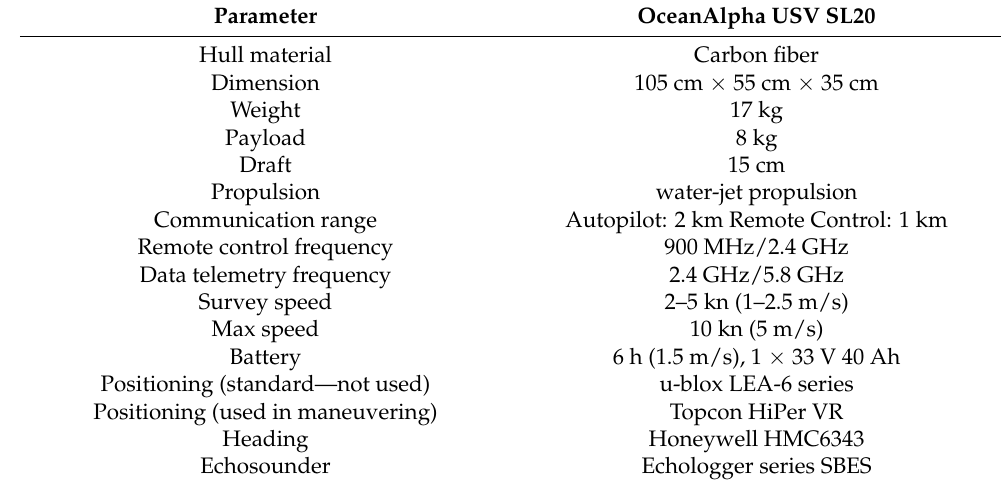
Figure 3. USV OceanAlpha SL20. Technical specification of the OceanAlpha USV SL20 is shown in Table 2.